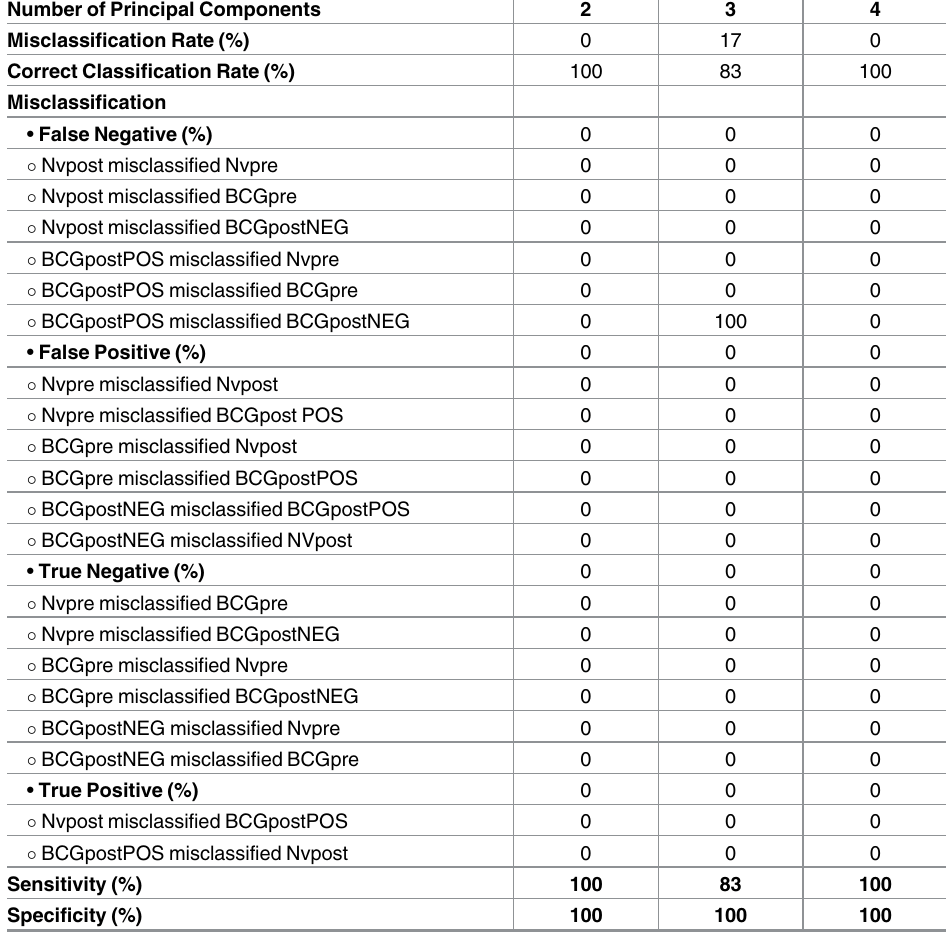
Table 3. Five way linear discriminant analysis classification of calves using 13